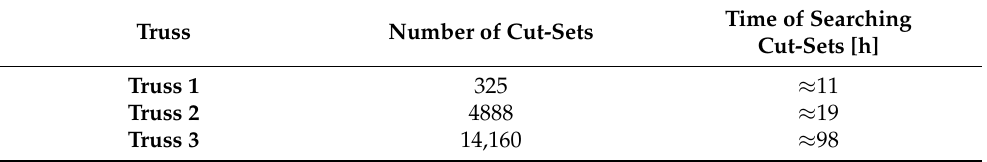
Table 4. The number and time of cut-sets searching for Trusses 1, 2, 3. Truss Number of Cut-Sets